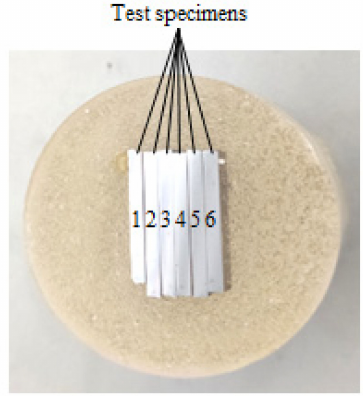
Figure 5. View of the specimens inlaid for the metallographic